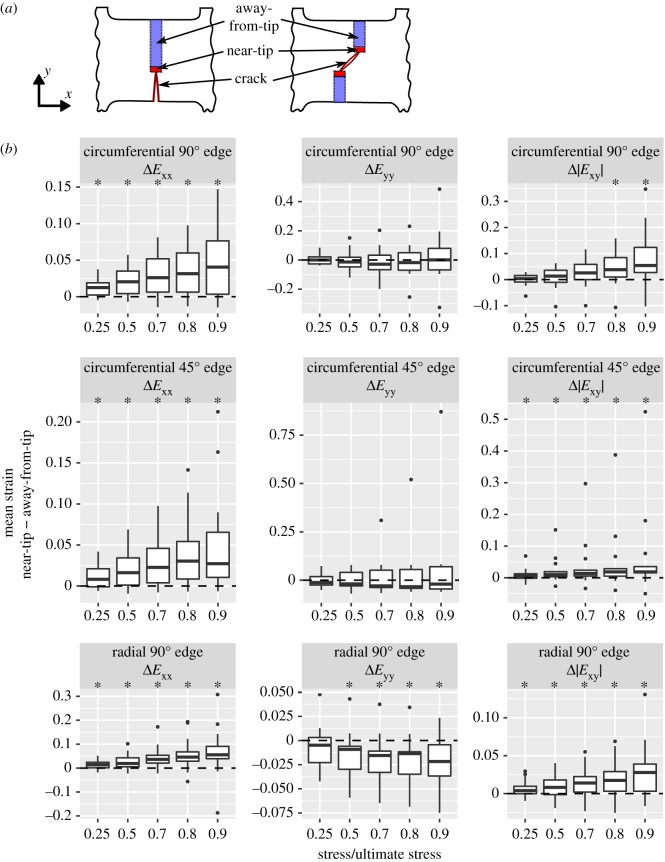
Strain field differences between near-tip and away-from tip ROIs within specimens. (a) Schematic of ROI definitions. (b) Tukey boxplots. Asterisks (*) indicate near ≠ away, Wilcoxon test, p < 0.05.